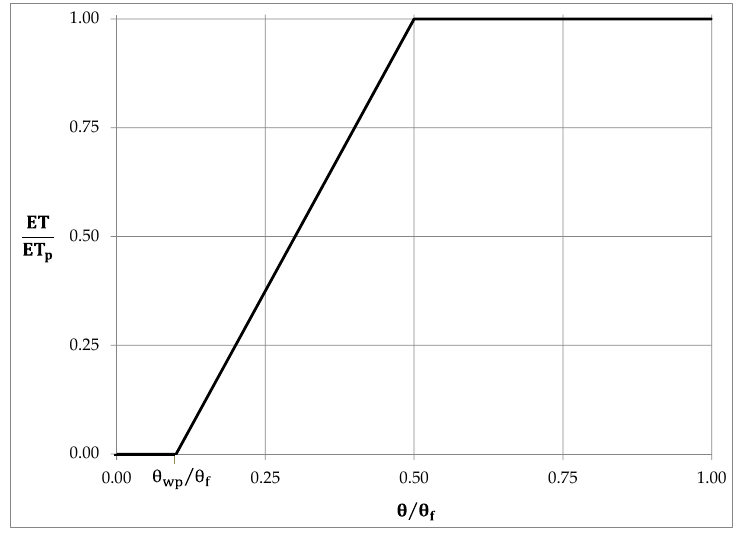
Figure 3. Relationship between evapotranspiration, ET, and soil moisture.